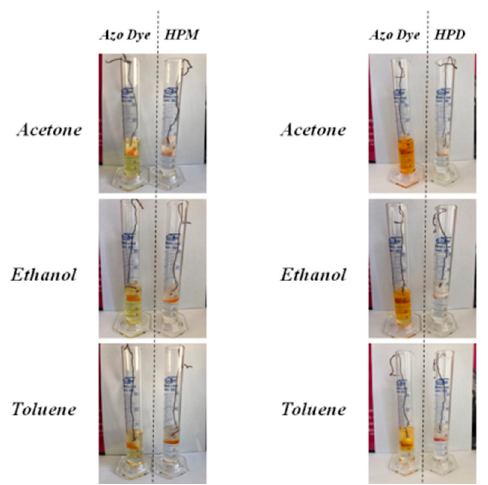
Figure 7. Digital photos of azo dye and hybrid pigment powders immersed in various organic